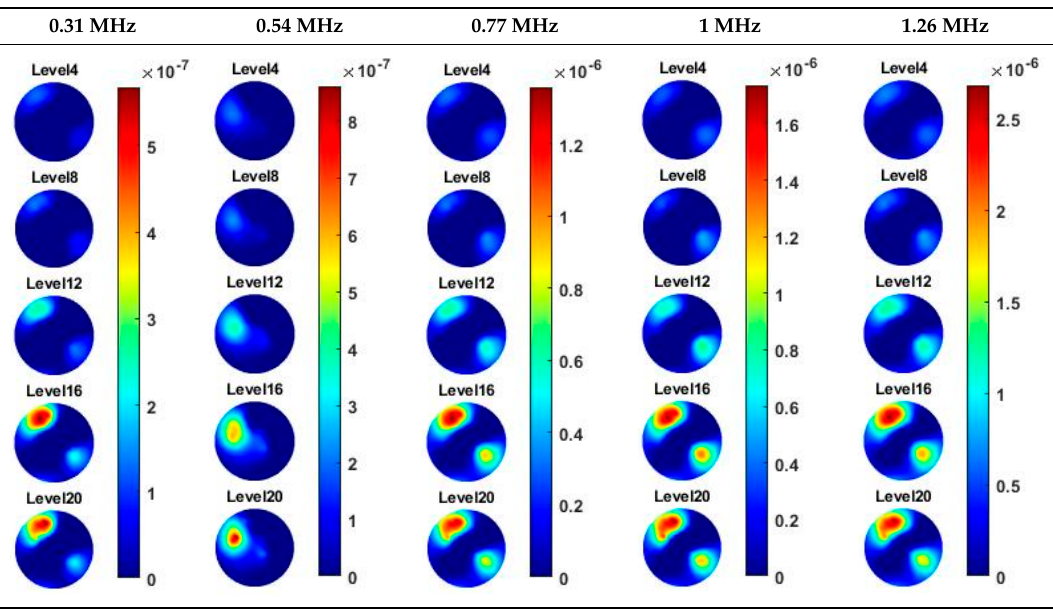
Table 4. Sliced image of horizontal layer for double corn kernels with multi-frequency. Table 3. Sliced image of horizontal layer for single corn kernel with multi-frequency.